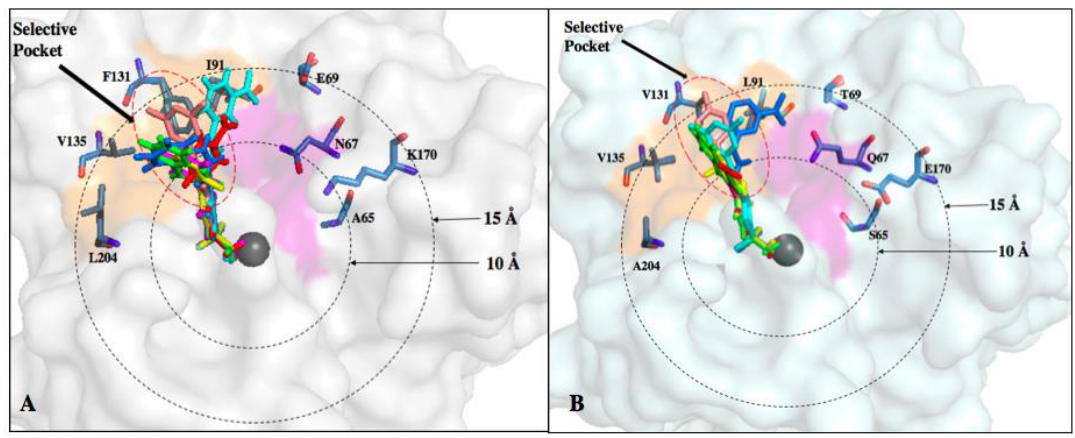
Figure 6. Stick representation of benzenesulfonamide-based and ureido-based benzenesulfonamide inhibitors in complex with the surface of CA II and CA IX. CAI binding in the active sites of ( A ) CA II (grey) and ( B ) CA IX-mimic (pale cyan) with residues in Zone II (10–15 Å) shown with concentric rings. Inhibitors are represented as sticks: 4-(phenyl) benzenesulfonamide (magenta), 4-(2’-methylphenyl) benzenesulfonamide (yellow), 4-(3’-formylphenyl) benzenesulfonamide (red), 4-(3’-quinolinyl) benzenesulfonamide (green), 4-{[(3-nitrophenyl) carbamoyl] amino} benzenesulfonamide (blue), (4-{[3,5-methylphenyl) carbamoyl amino} benzenesulfonamide (salmon) and 4-{[(4-fluorophenyl) carbamoyl] amino} benzenesulfonamide